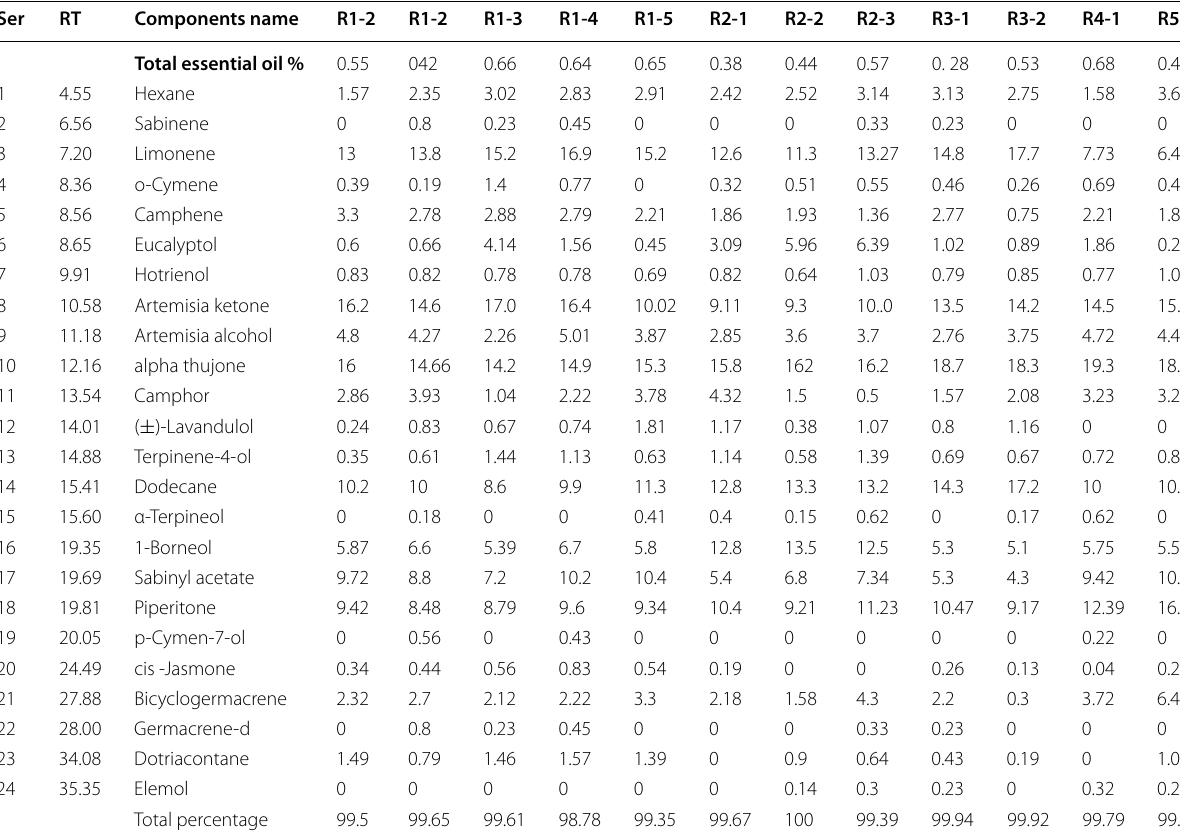
Table 5 Retention time and components name and percentage of each compound in the essential oil extracted from 12 regenerated plants representing 12 individual samples of six populations of A. fragrantissima